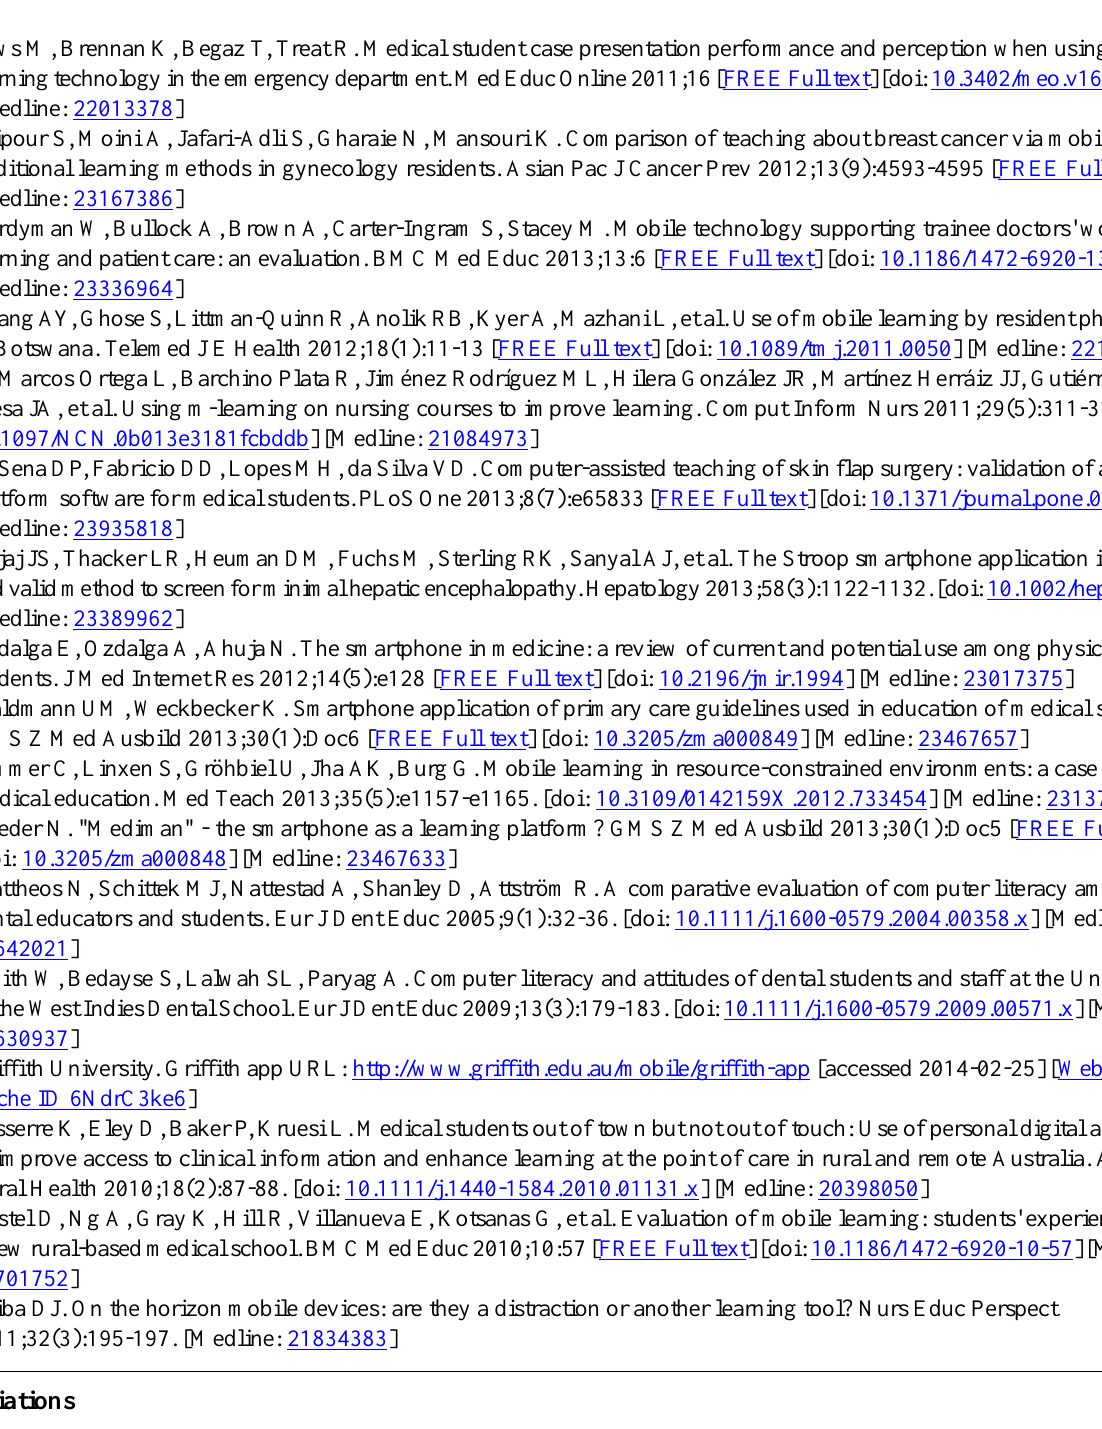
3G: third generation ICT: information and communication technology VAS: visual analogue